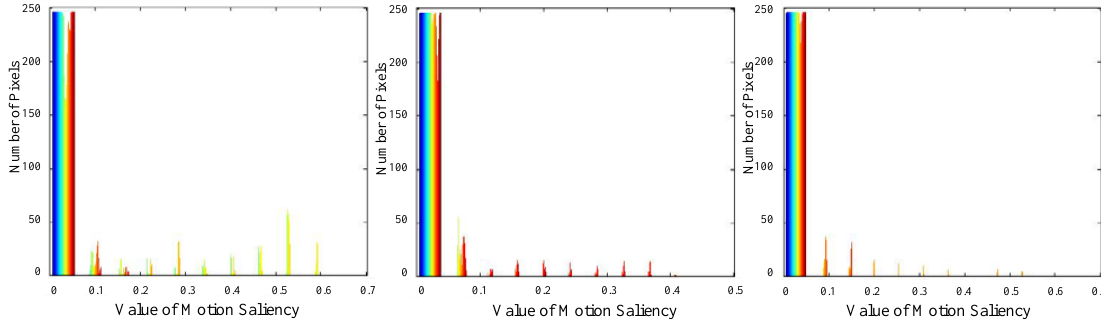
Figure 4. Histograms of motion saliency